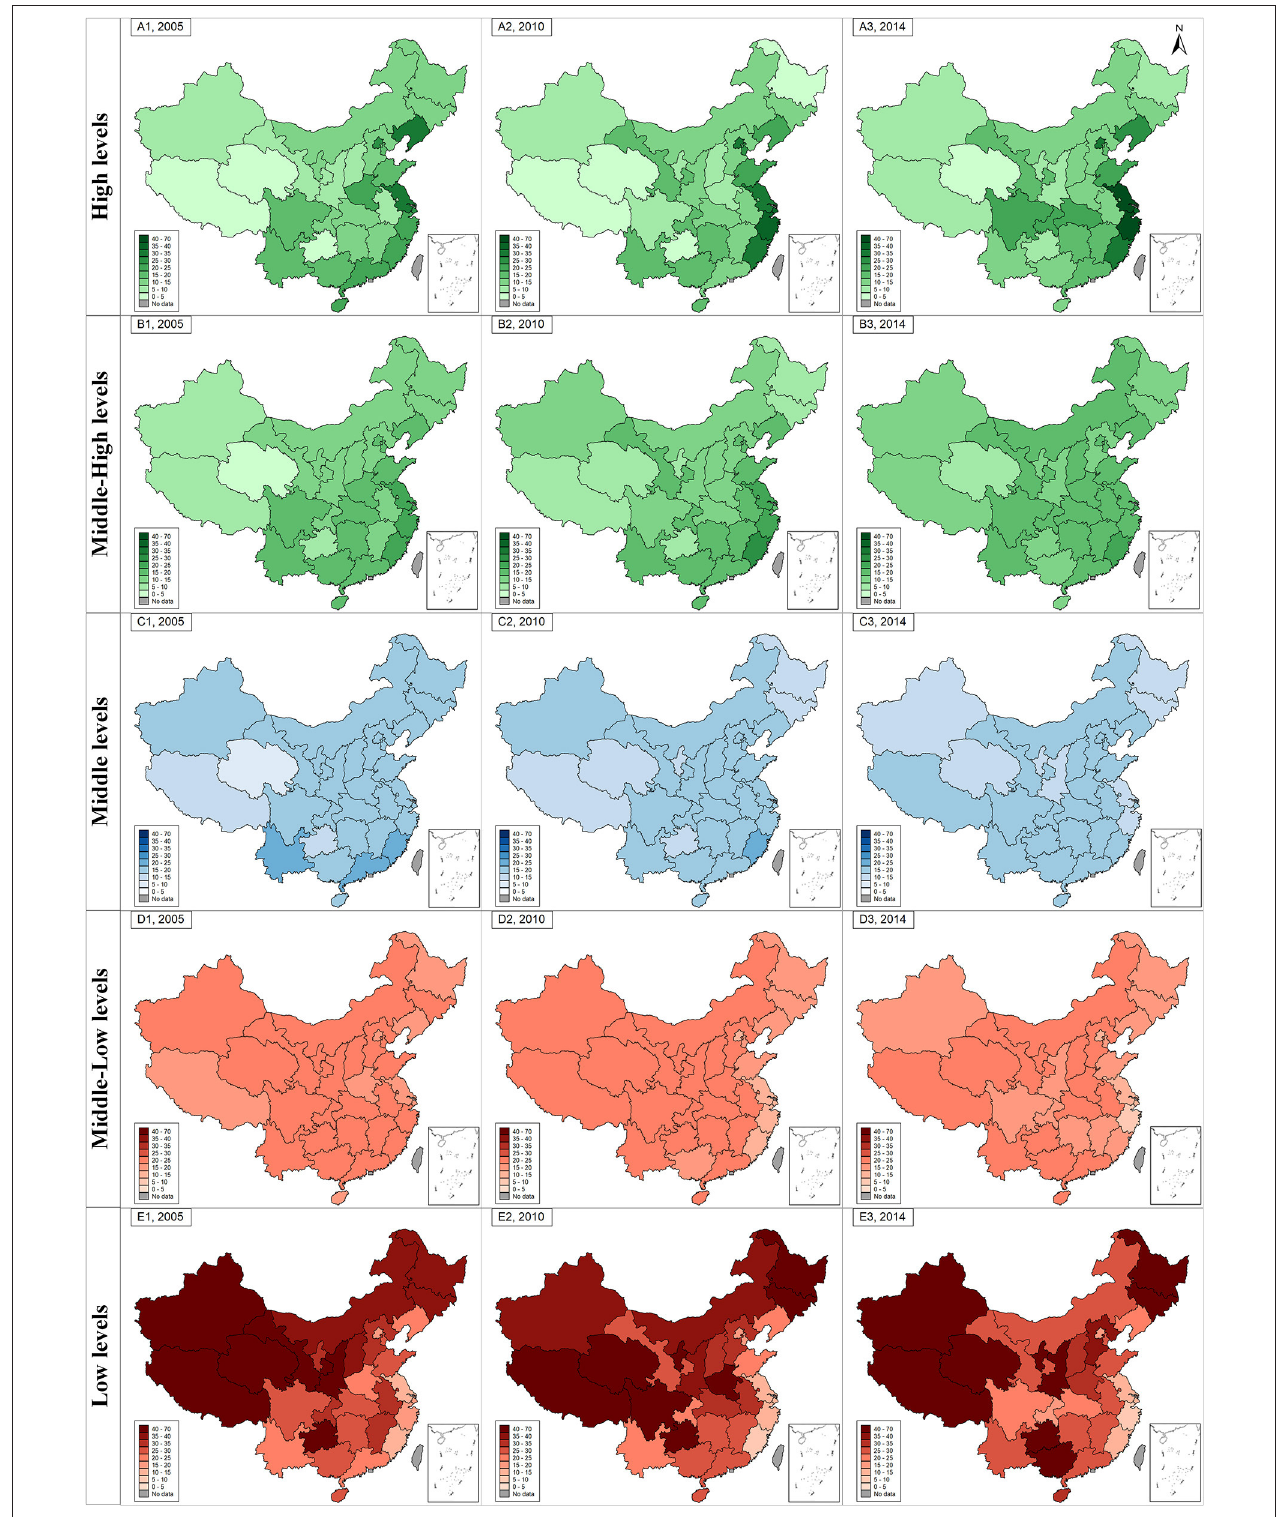
FIGURE 3 | The geographical distribution and changes of different levels of physical fitness index from 2005 to 2014 (2005–2014, China). The green graph in subfigure ( A1 , A2 , and A3 for 2005, 2010, and 2014) and ( B1 , B2 , and B3 for 2005, 2010, and 2014) represents geographical distribution of high levels of PFI and middle-high levels of PFI in 2005, 2010, and 2014. The blue graph in subfigure ( C1 , C2 , and C3 for 2005, 2010, and 2014) represents geographical distribution of middle levels of PFI in 2005, 2010, and 2014. The red graph in subfigure ( D1 , D2 , and D3 for 2005, 2010, and 2014) and ( E1 , E2 , and E3 for 2005, 2010, and 2014) represents geographical distribution of low levels of PFI and middle-low levels of PFI in 2005, 2010, and 2014. The gradient of each color series in each subfigure was used to show the exact proportions of the specific PFI levels (exact number showed in Supplementary Table 2 ).